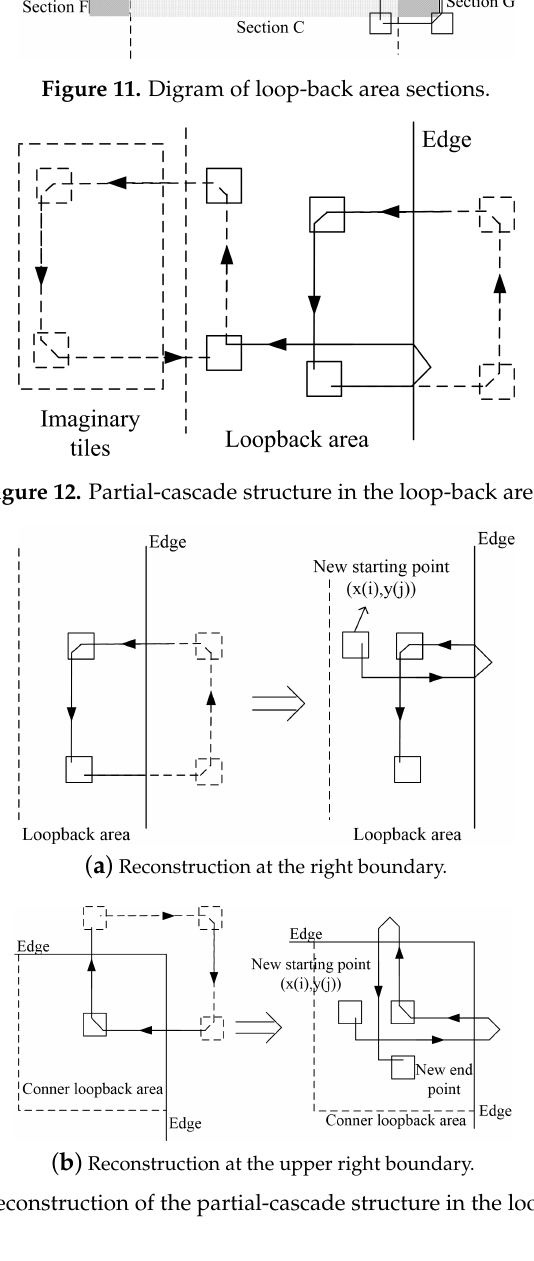
( a ) Reconstruction at the right boundary.